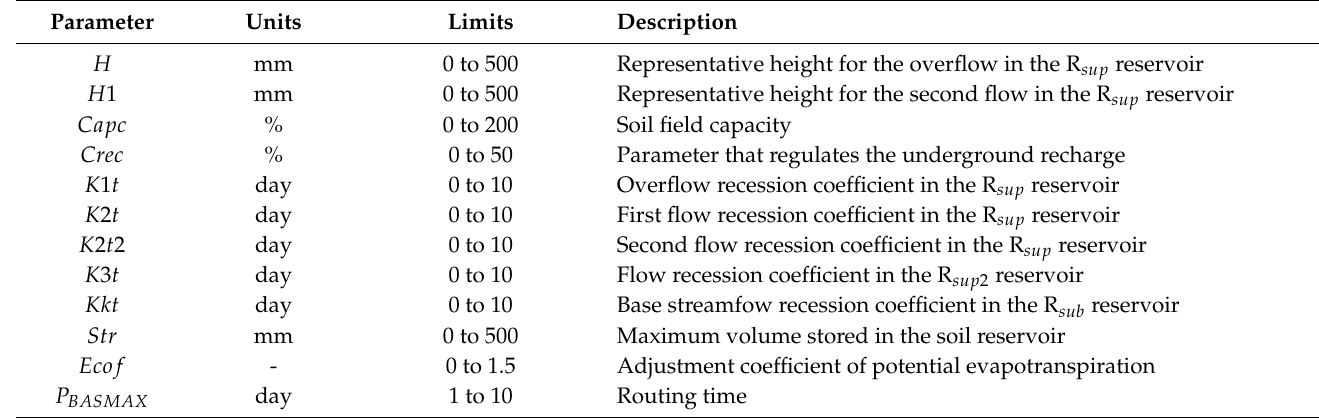
Table 4. Description of main parameters of the SMAP/ONS model